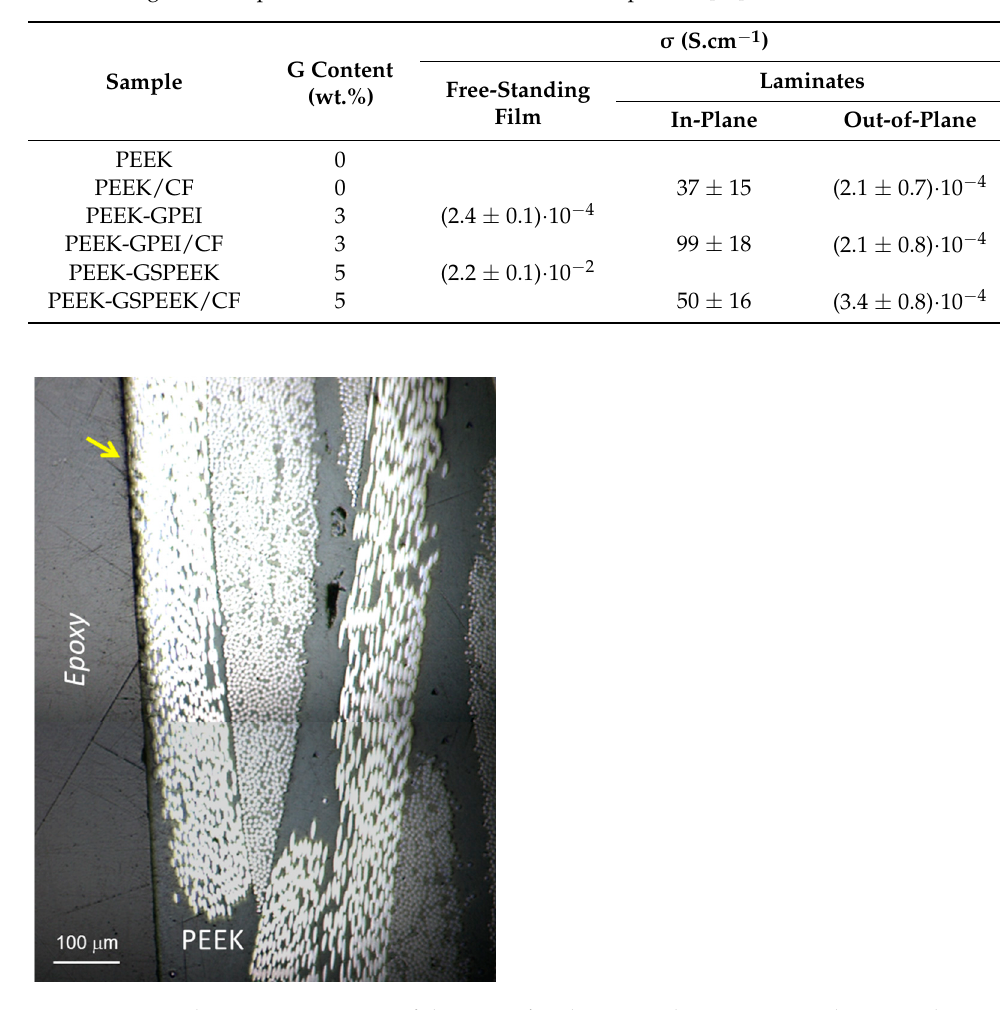
Table 3. In-plane and out-of-plane conductivity values of all laminates. Conductivity values for the free-standing nanocomposite films are also included for comparison [31].